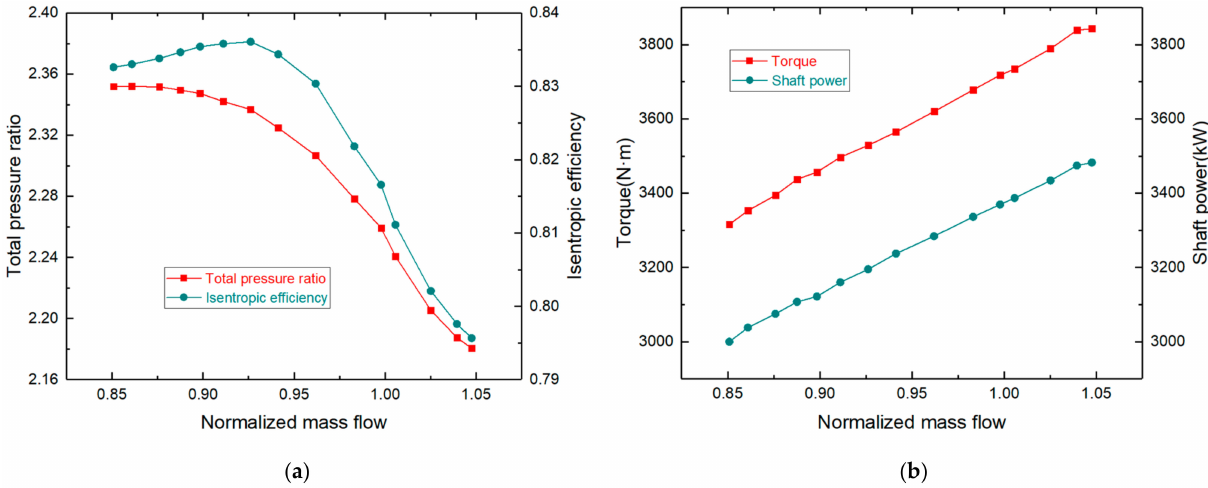
Figure 6. Characteristic curve of centrifugal compressor: ( a ) total pressure ratio and isentropic efficiency; ( b ) torque and shaft